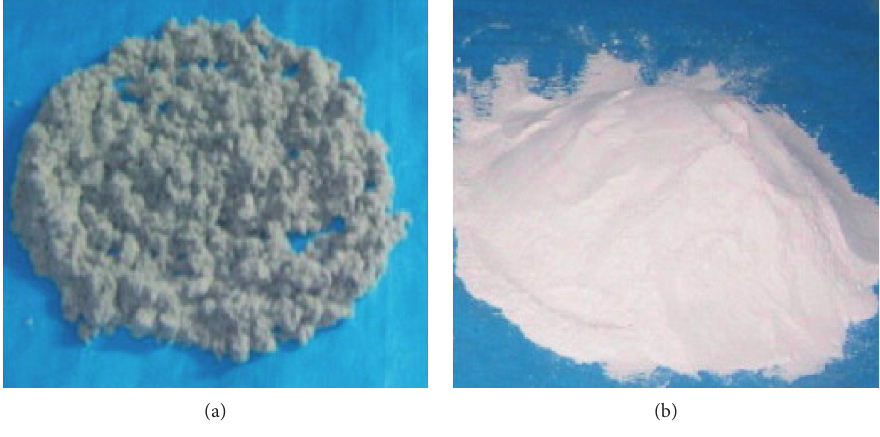
Figure 1: (a) cotton waste and (b) limestone powder. Table 2: The properties of cotton waste (CW), lime powder waste (LPW), and cement